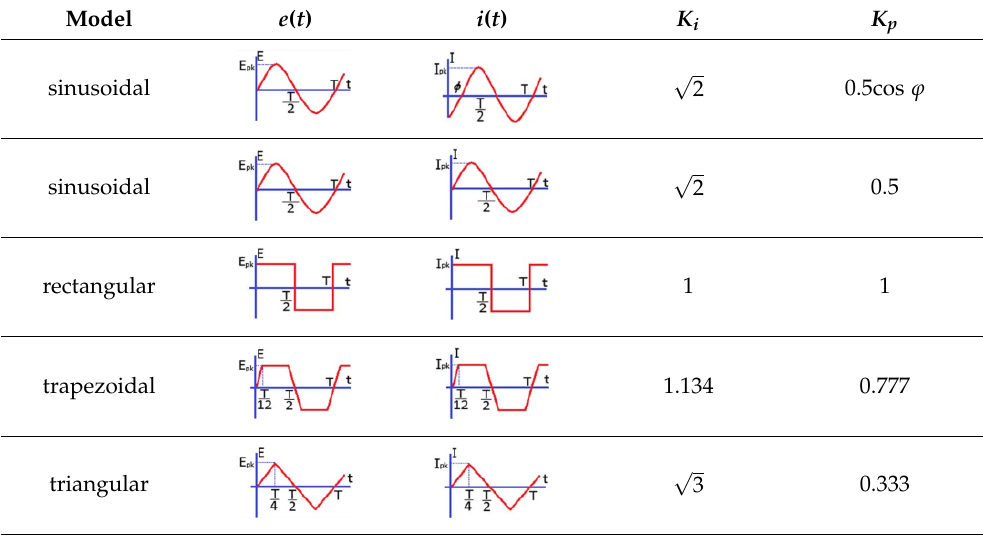
Table 2. Typical Prototype Wave Forms [17].